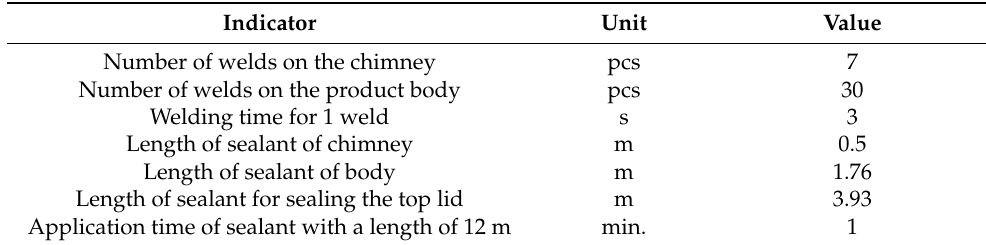
Table 9. Input data for calculation of welding and sealing operations by robots. Indicator Unit Value Number of welds on the chimney